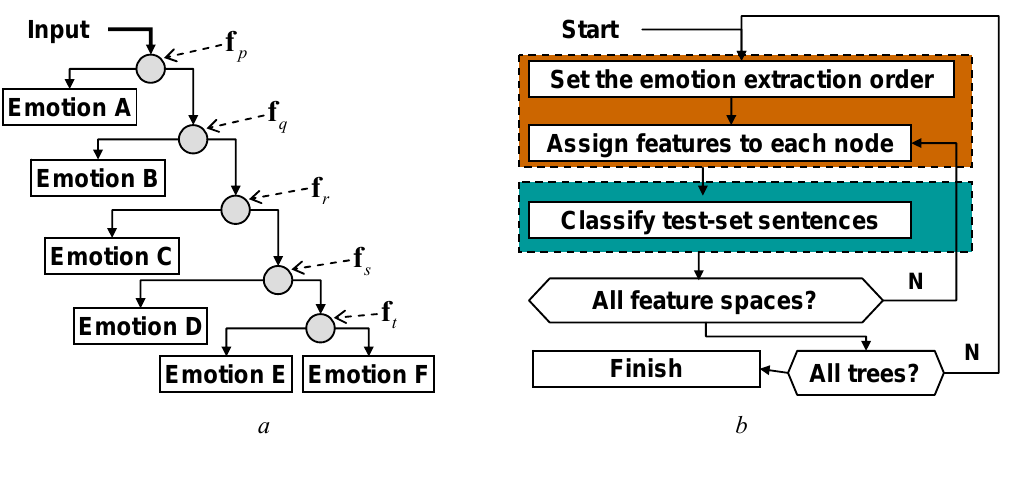
Figure 5. A structure of the adopted binary decision trees, where five different feature sets ( f p , f q , f r , f s , f t ) are used for classification at each node (a); block diagram of the feature selection process, where the tree generation is highlighted in orange and classification—in cyan